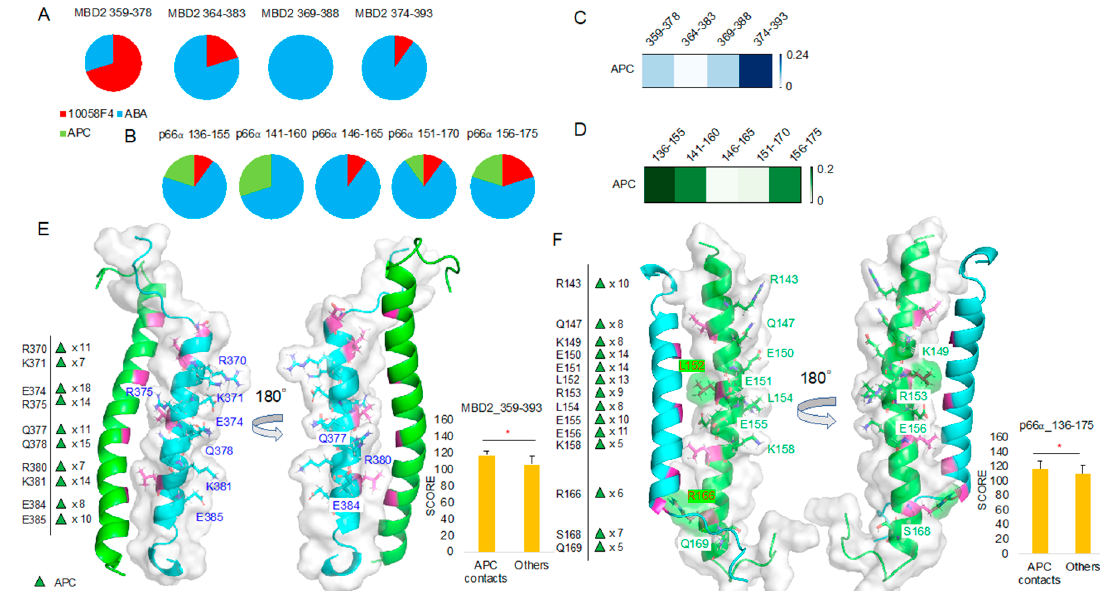
Figure 7. Molecular docking toward MBD2 and p66 α , and APC focused docking result analysis: ( A , B ) 10058F4, ABA, and APC molecular docking toward MBD2 (A) and p66 α (B) and the corresponding 10 best result distribution pie charts. ( C , D ) APC-focused docking result T score heatmap from MBD2 docking (C) and p66 α docking (D). ( E ) MBD2 (cyan) contact residues shown on the MBD2–p66 α complex (PDB ID 2L2L) [15] and the corresponding new docking evaluation score (y-axis) t -test between contact cases and others. ( F ) p66 α (green) contact residues shown on the MBD2–p66 α complex (PDB ID 2L2L) [15] and the corresponding new docking evaluation score (y-axis) t -test between contact cases and others. * p -value < 0.001.